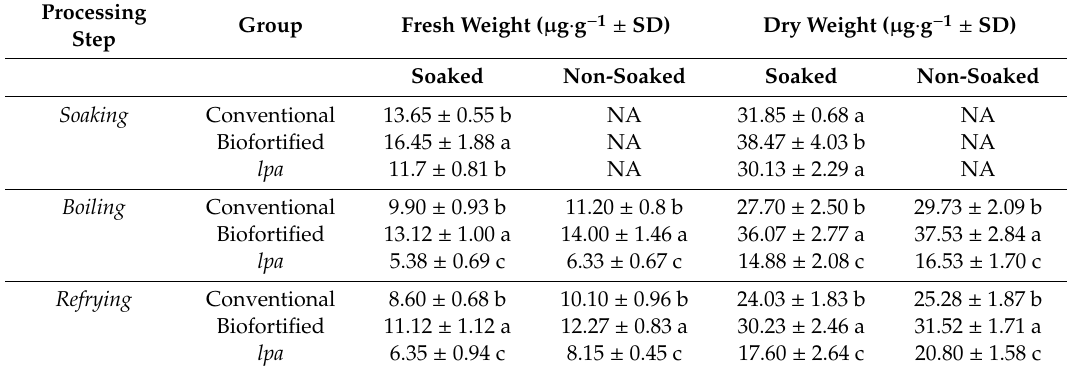
Table A2. Fresh and dry weight ( µ g · g − 1 ± SD) for zinc of three groups of beans after five di ff erent processing steps.